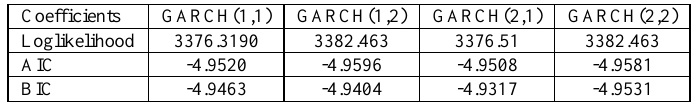
Table 3. AIC, BIC, Loglikelihood coefficients for the Hindalco daily high